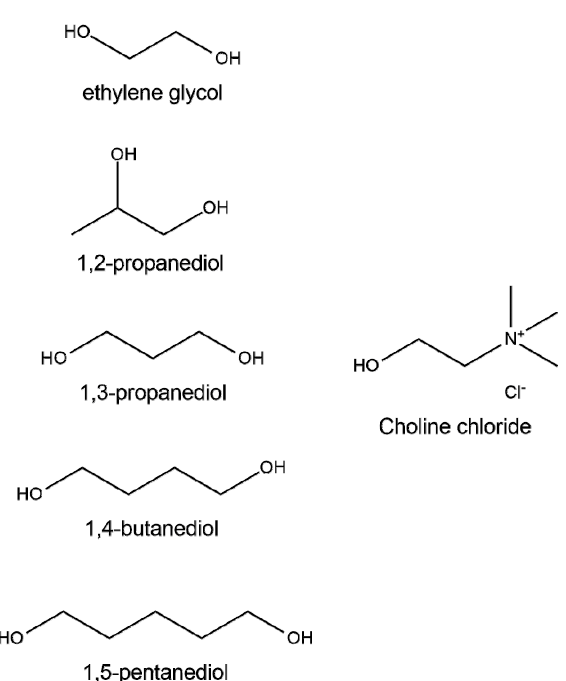
Figure 1. Structures of the compounds used in this